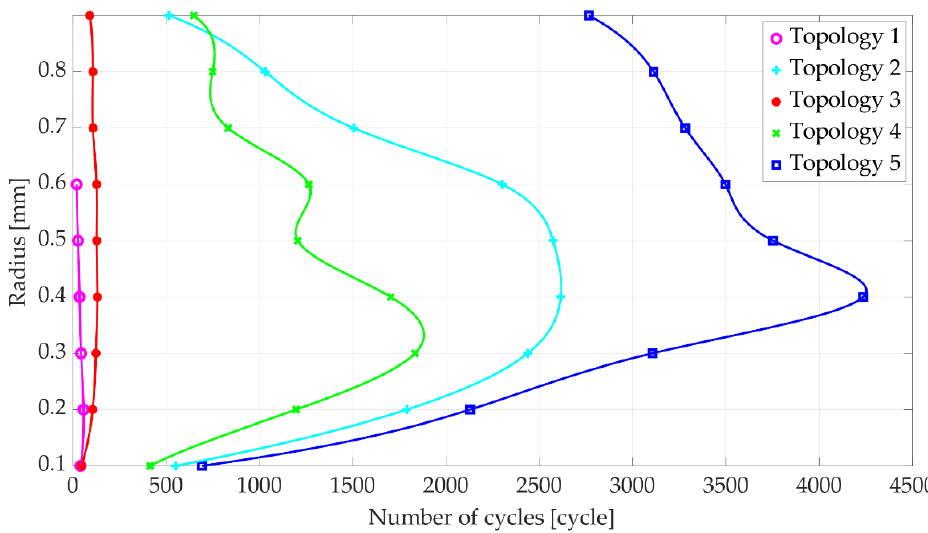
Figure 11. The fatigue life N i of different topologies and fillet radiuses.